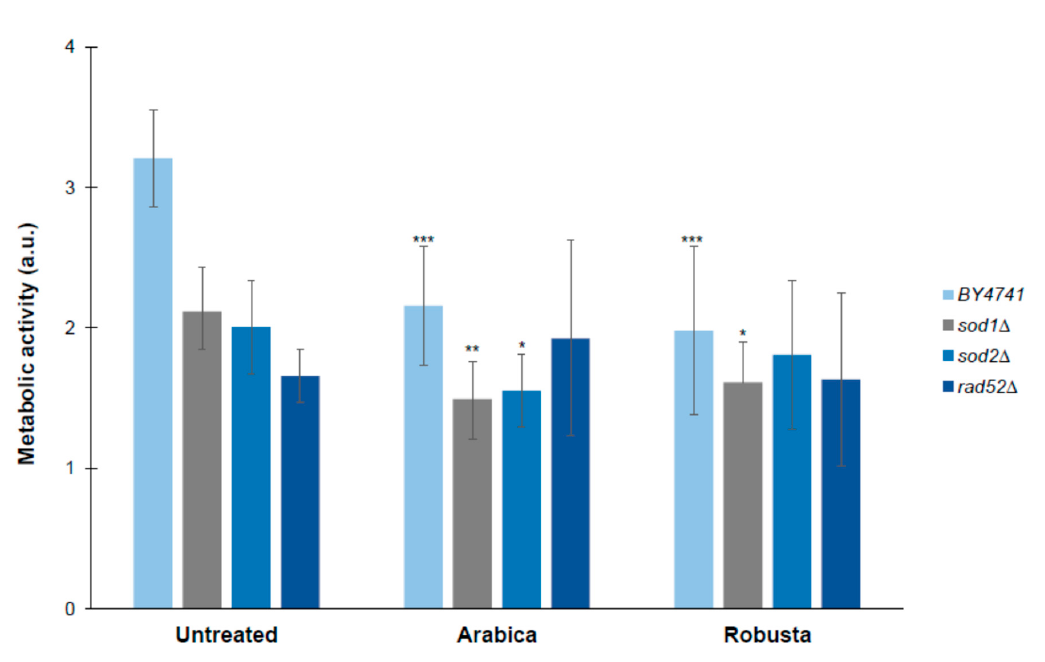
Figure 6. Metabolic activity of the cells (red/green ratio) was estimated with FUN-1 stain. Data are expressed as ratio of red ( λ = 575 nm) to green ( λ = 535 nm) fluorescence and presented as mean ± SD from three independent experiments. Bars indicate SD. Statistical significance was assessed using ANOVA and the Dunnett’s post hoc test (* p < 0.05; ** p < 0.01, *** p < 0.001) compared to the control (untreated).